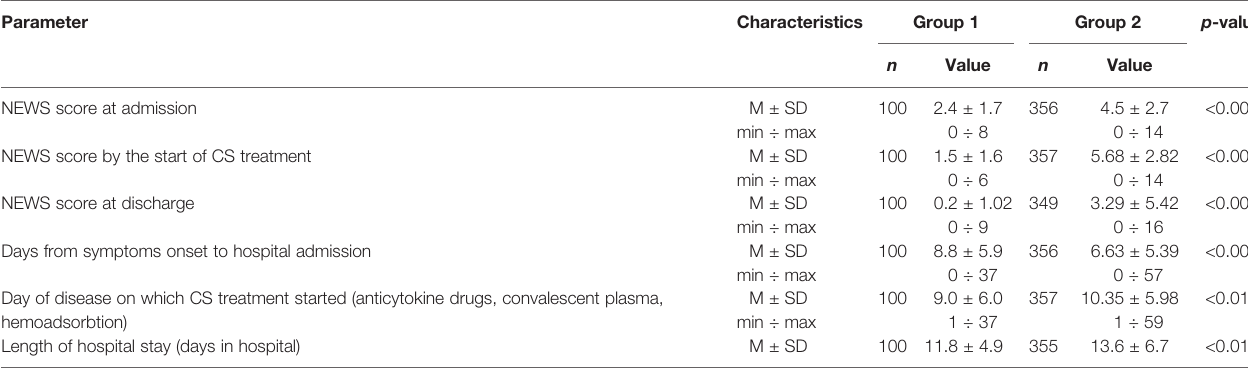
TABLE 3 | Between-group differences in NEWS score, time from symptoms onset to hospital admission, and length of hospital stay.